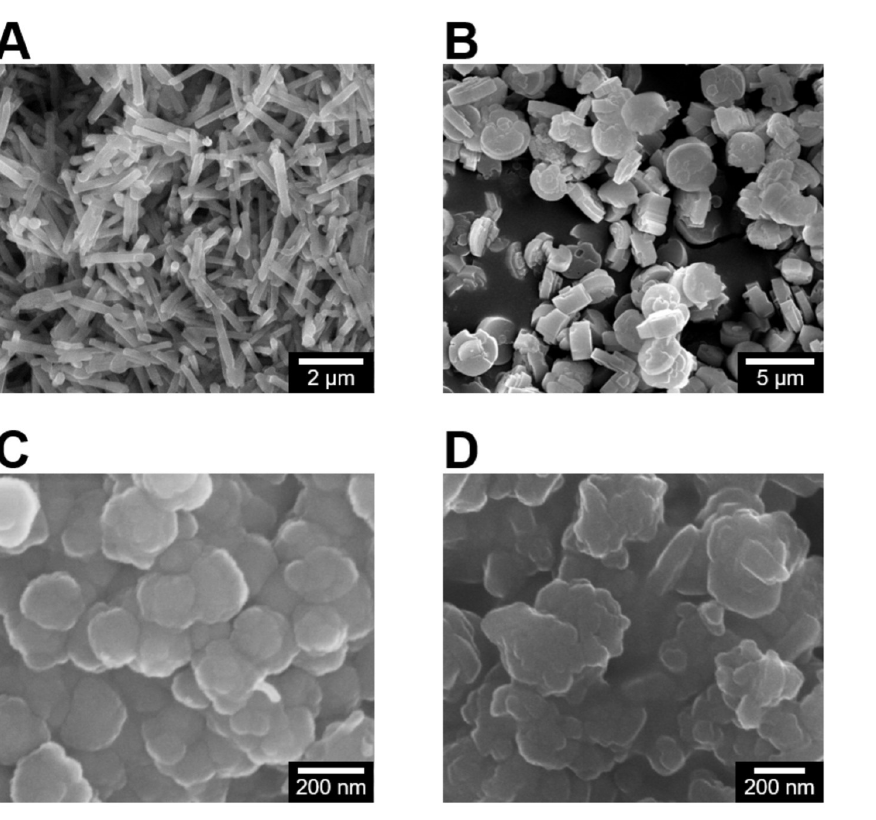
Figure 1. Scanning electron micrographs of the following as synthesized zeolite particles: ( A ) LTL-R,